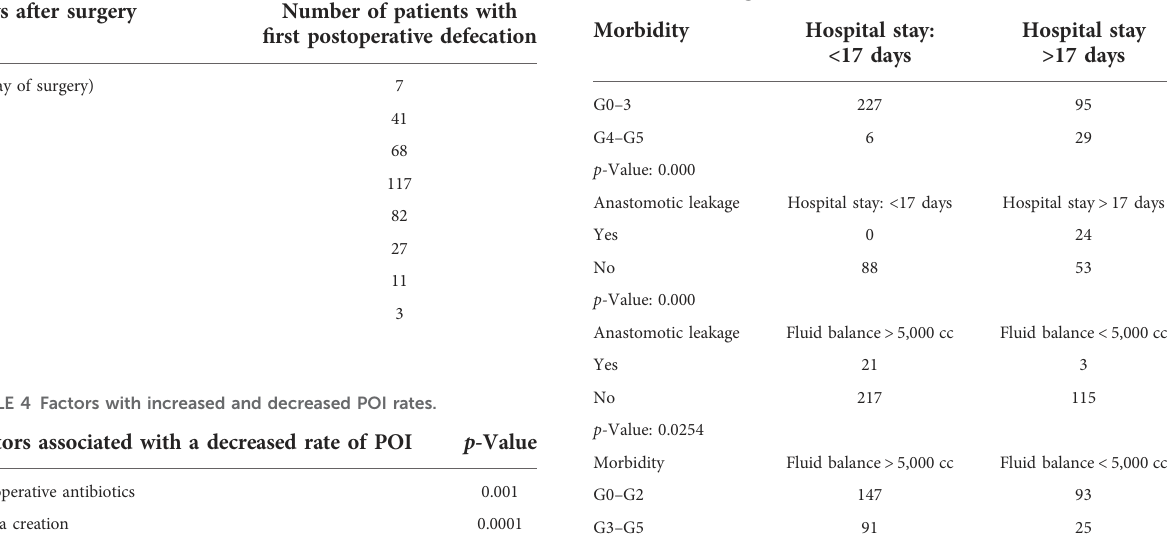
TABLE 3 First defecation after surgery.